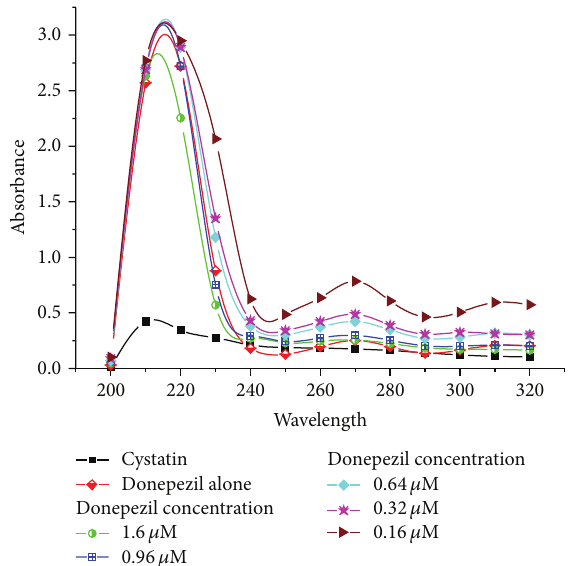
Figure 4: UV-vis spectra of cystatin in the presence and absence of